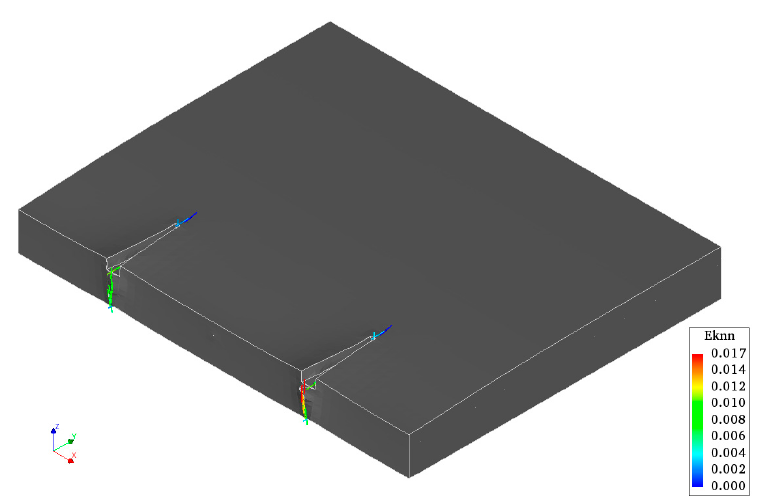
Figure 11. Crack initiation in CRCP from the saw-cuts.